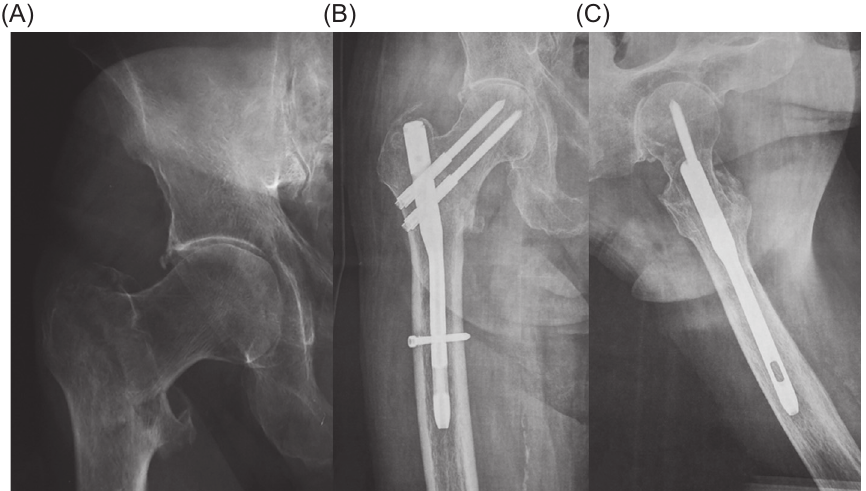
Figure 2. (A) Anteroposterior radiograph of the right hip of a 75-year-old man shows an AO/OTA-31-A1 fracture. (B) Anteroposterior and (C) lateral radiographs of the right hip nine months after surgical treatment show fracture healing. The patient was alive with excellent